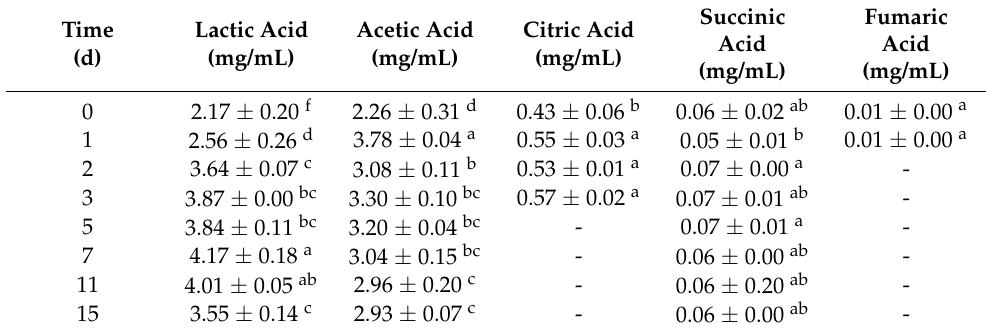
Table 3. Changes of organic acids in